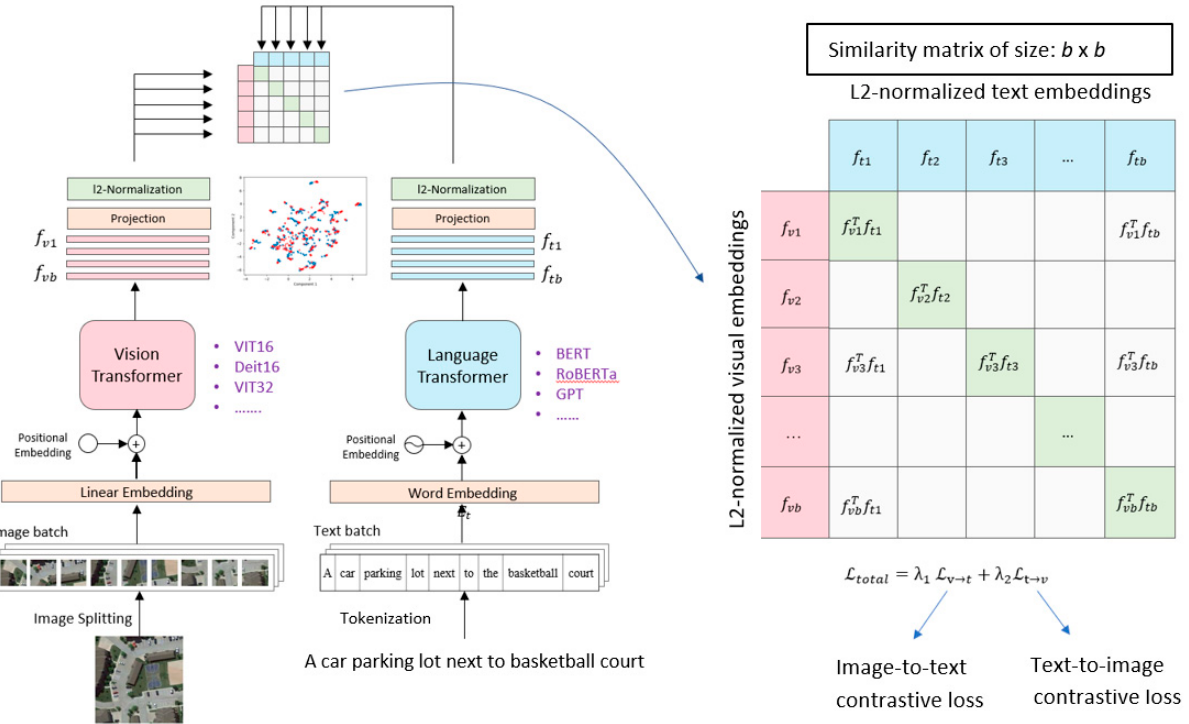
Figure 2. Overview of the proposed text–image aligning model. To produce L2-normlized visual { f } b and textual { f ti } b features, we sample a mini-batch of b images-text pairings for training the network and feed them to the vision and language transformer encoders. Then, we generate a similarity matrix of size b × b by calculating the similarity between all potential visual and textual pairs in the mini-batch .